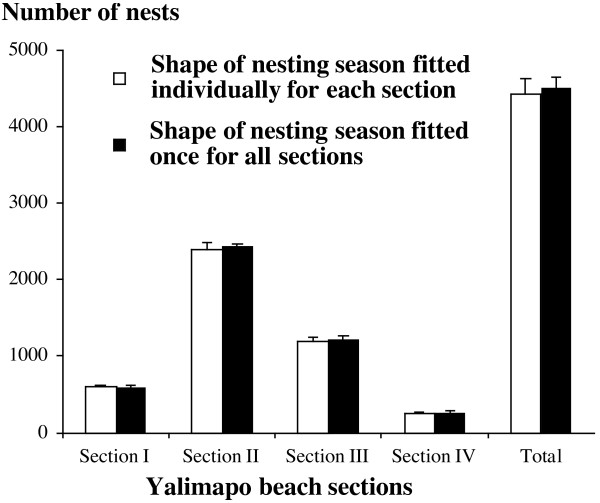
Estimated nest numbers for various beach sections if each beach section was fitted using its own model (4 different models, open bars) or if a single fitted model was used for all beach sections (1 single model, closed bars).